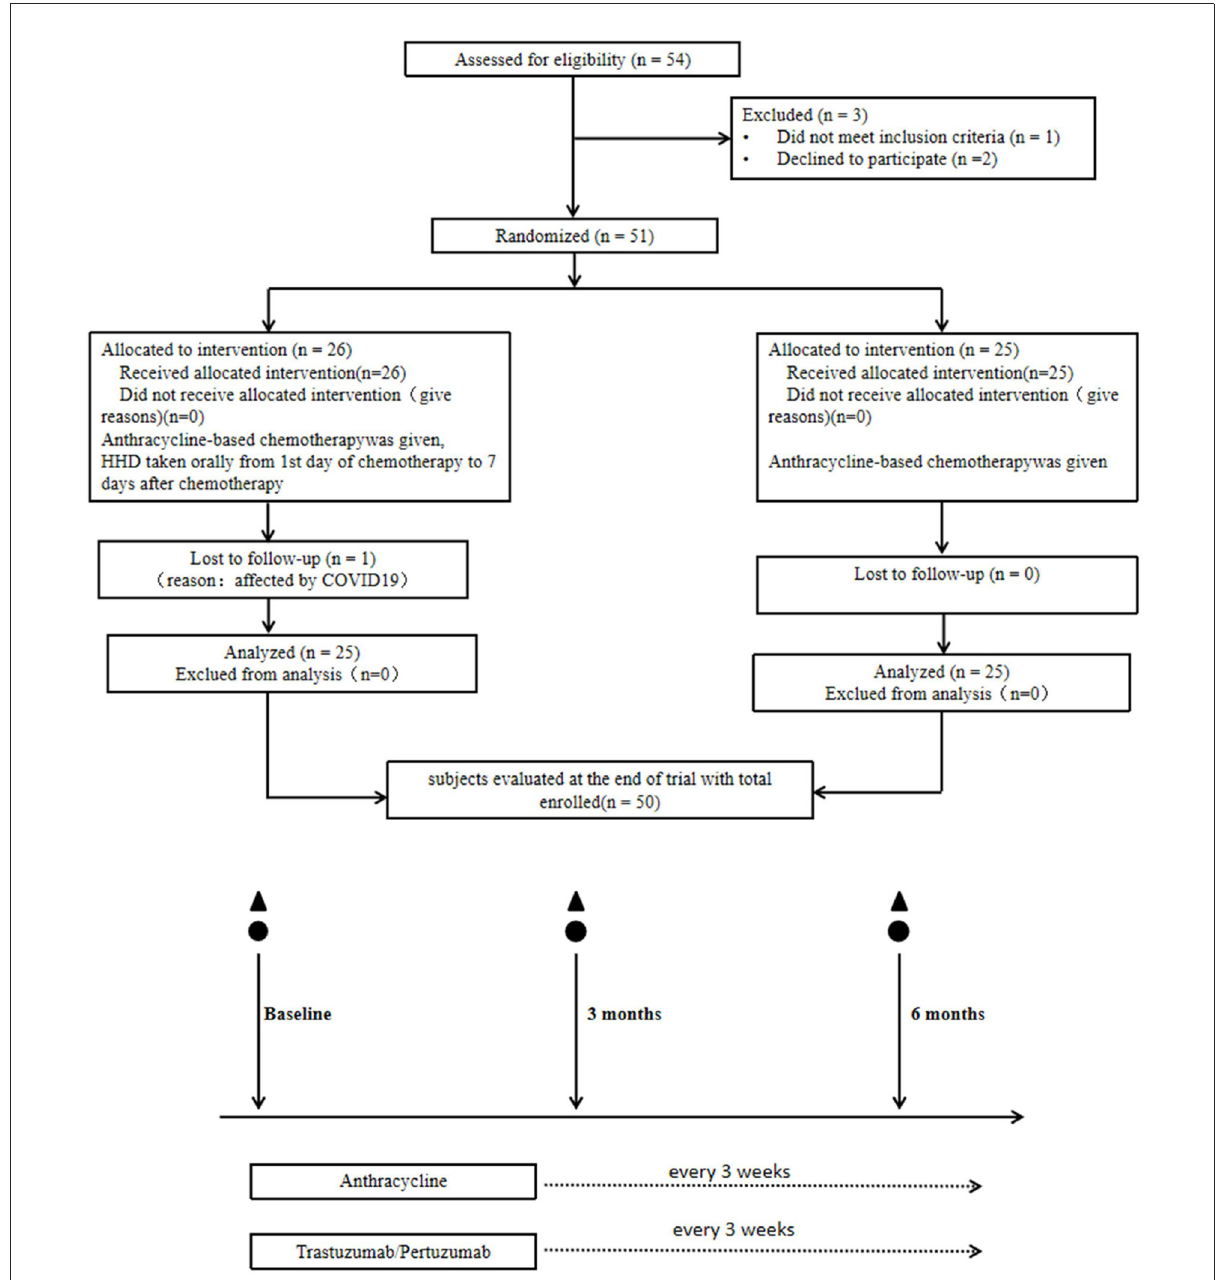
FIGURE1 Participant flow through the trial. N , echocardiogram with speckle-tracking strain analysis; (cid:8) , myocardial enzymes, brain natriuretic peptide, oxidative stress, inflammatory factors in plasma measured pre- and post-chemotherapy infusion every 3 months at 0, 3, and 6